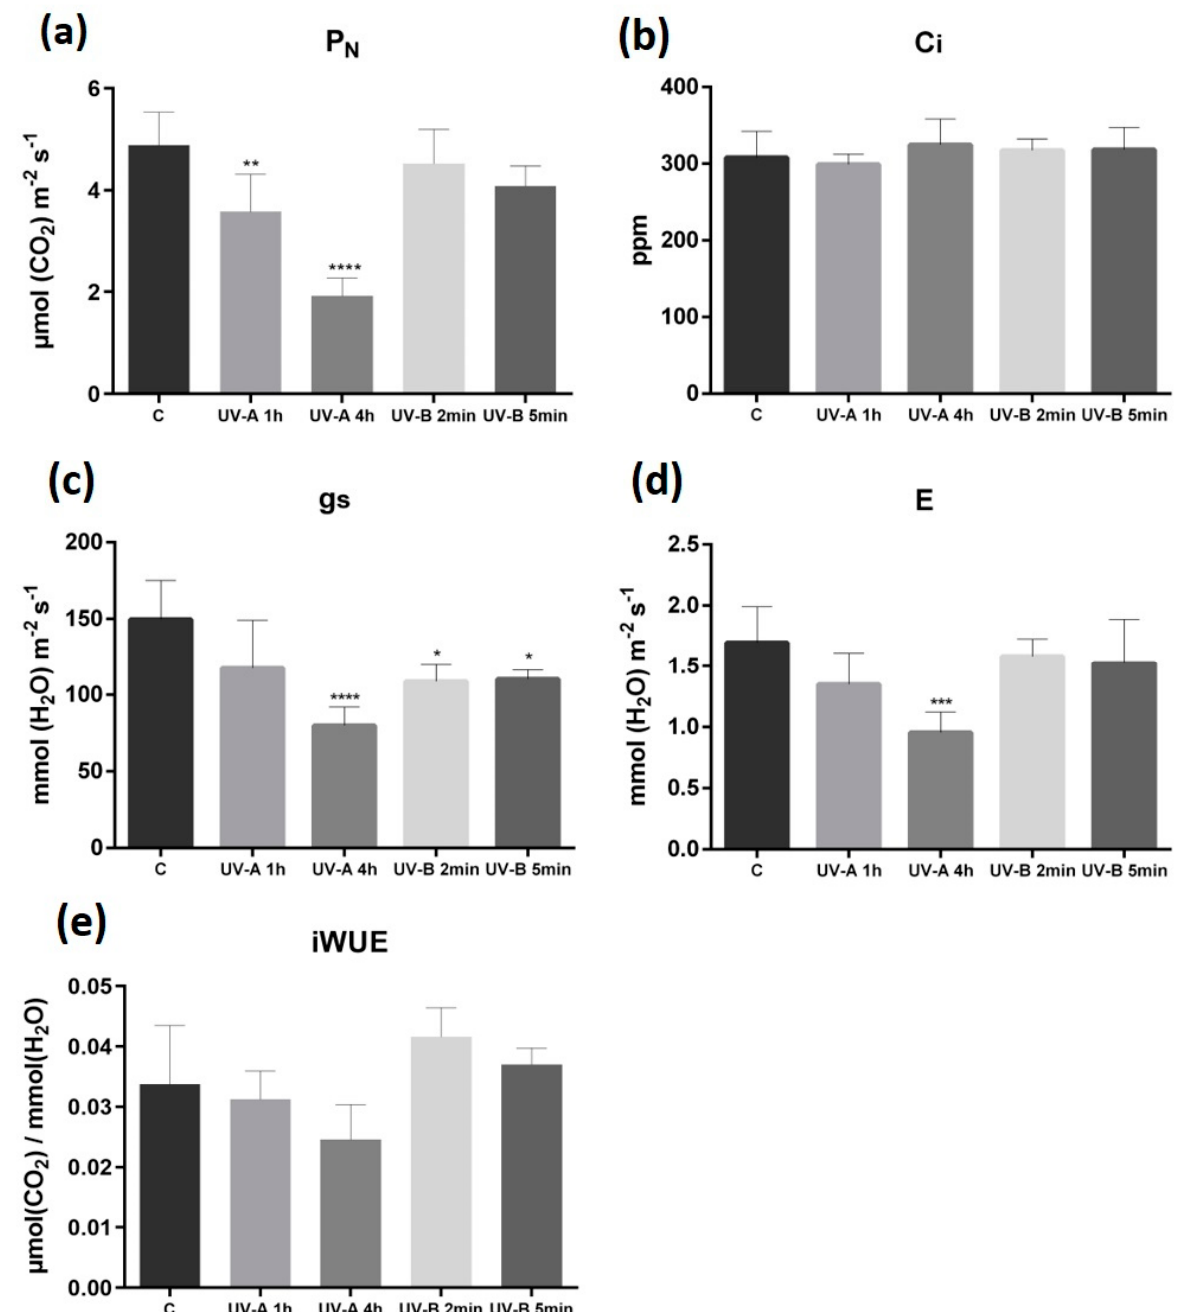
Figure 2. Leaf gas-exchange after 30 d of exposure to different UV-A/B conditions. Net photosynthetic rate, P N ( a ); intercellular CO 2 concentration, Ci ( b ); stomatal conductance, gs ( c ); transpiration rate, E ( d ); intrinsic water-use efficiency iWUE, (P N /gs) ( e ). Within each parameter, *, **, *** and **** represent significant differences for p ≤ 0.05, 0.01, 0.001 and 0.0001, respectively. Values are expressed as the mean and standard deviation (n = 6).